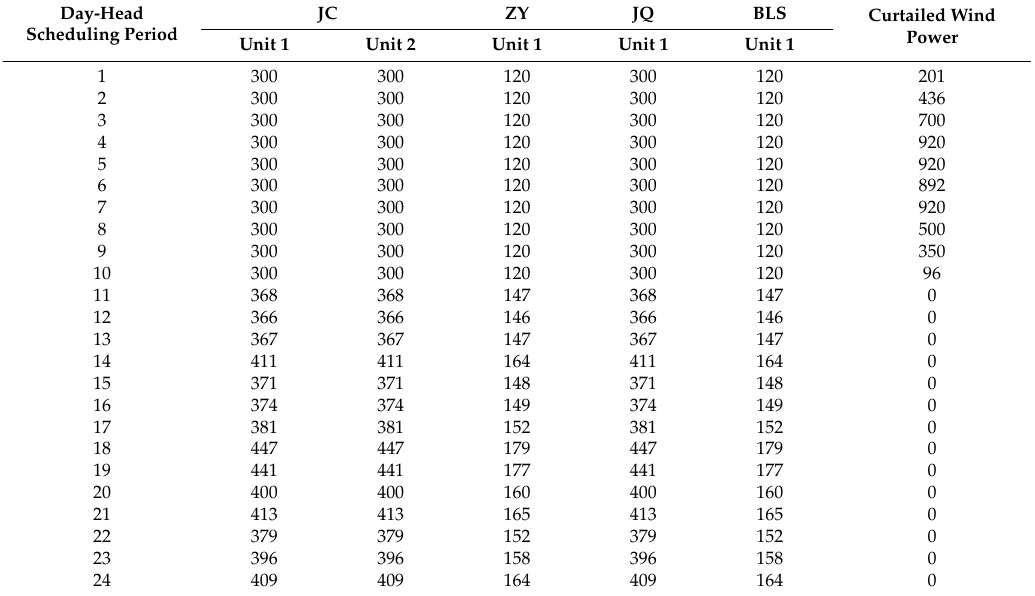
Table 4. Original day-head generation schedules and curtailed wind power / (MW).